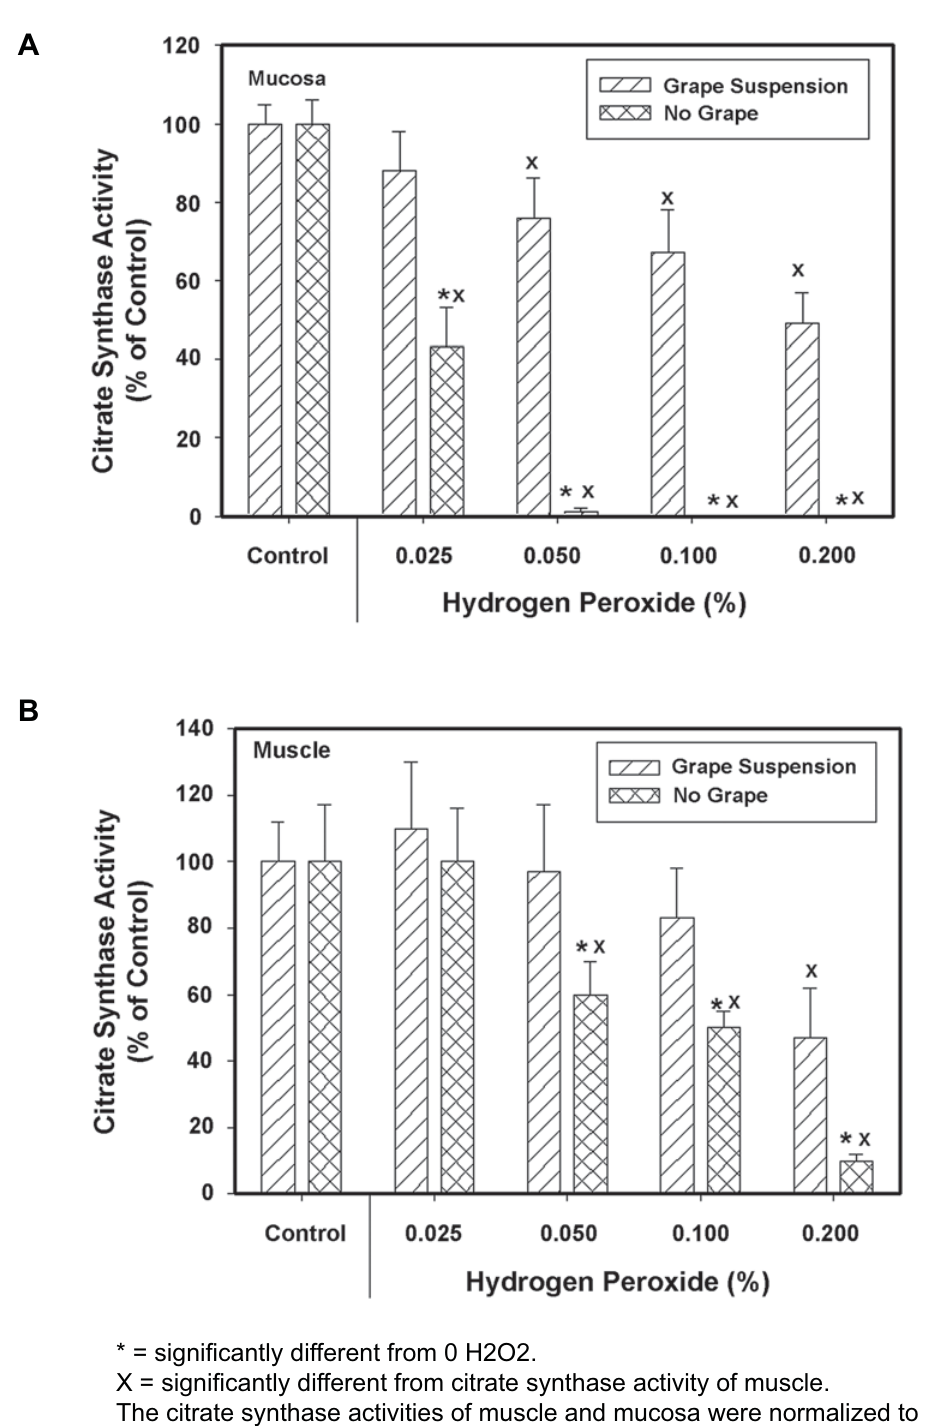
Figure 3 – Comparison of the effect of H2O2 on the citrate synthase activities of mucosa (A) and muscle (B). Each bar is the mean ± SEM of 6 individual